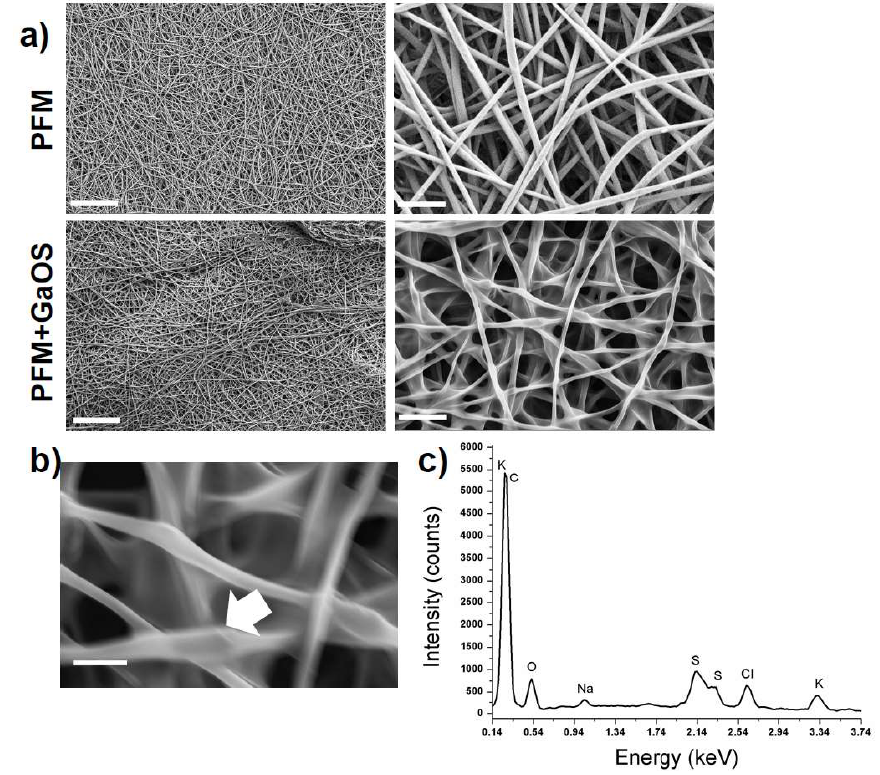
Figure 2. Microstructural characterization of the neat and GaOS doped PLA fibrous membranes (PFM). ( a ) SEM micrographs of PFM and PFM+GaOS ( left : magnification 1k×, scale bar 50 μm, right : magnification 10k×, scale bar 5 μm); ( b ) SEM micrograph (magnification 30k×, scale bar 2 μm) and ( c ) energy dispersive X-ray (EDS) spectrum of PFM+GaOS. The white arrow indicates the area submitted to the EDS microanalysis.